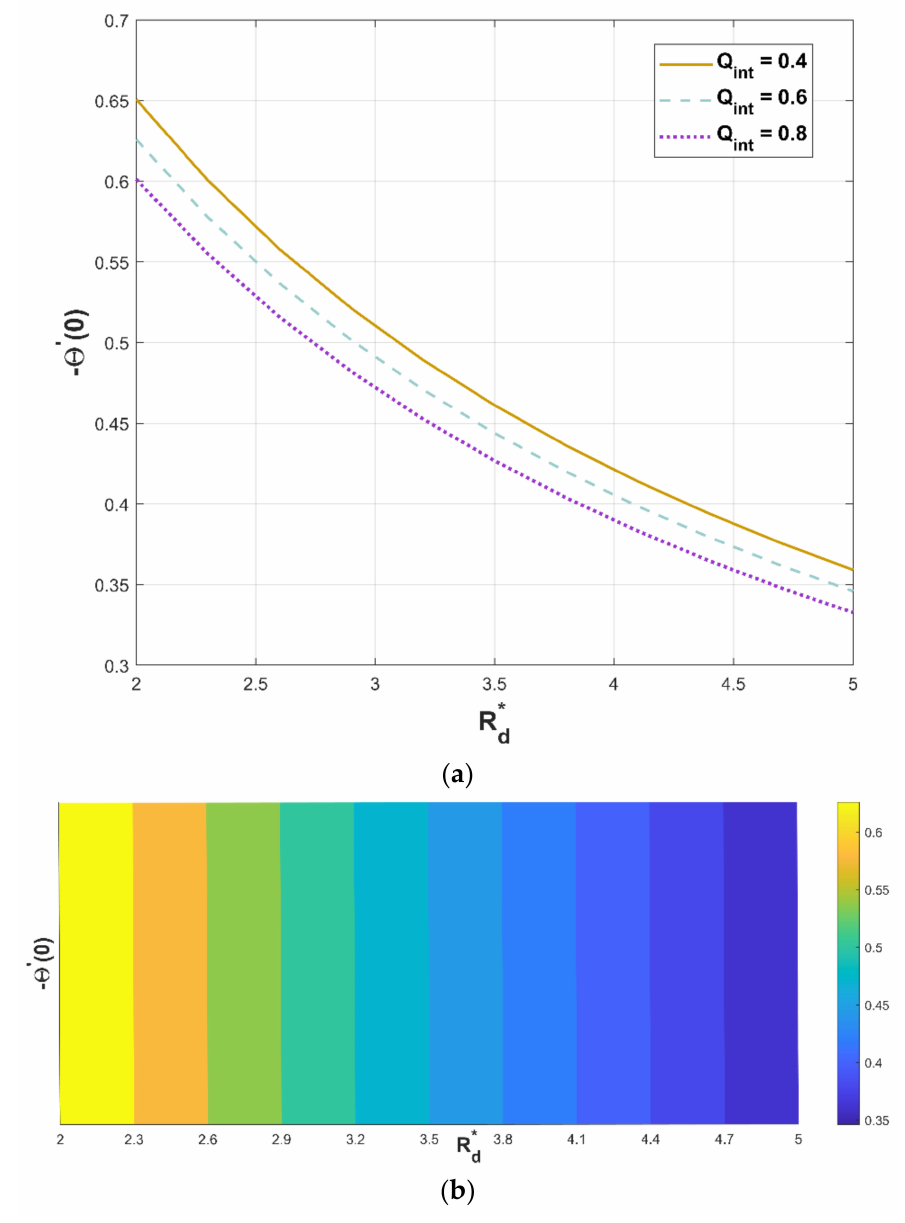
Figure 14. ( a , b ). Upshot of Q int and R ∗